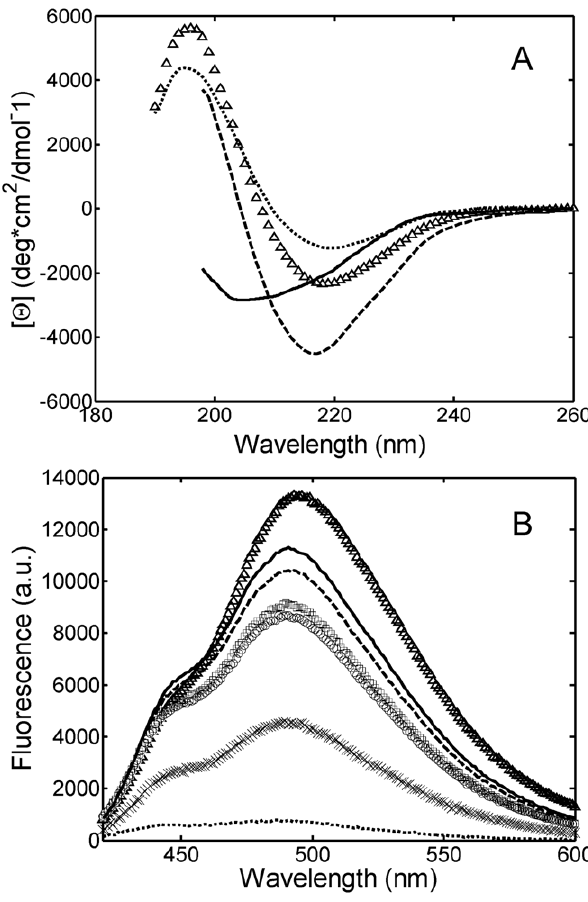
Figure 4. Light chain structural changes induced by salt addition monitored by CD (A) and ANS binding (B). Experiments were performed at 20 u C for a 0.3 g/L protein solution in 25 mM PBS at pH 7.4 (...) and in 20 mM HCl buffer at pH 2.0 without salt ( n ), with 0.15 M NaCl (–),0.15 M Na 2 SO 4 (_), 0.45 M NaCl ( # ), 0.49 M NaH 2 PO 4 ( % ) and 0.5 M Na 2 SO 4 ( 6 ).